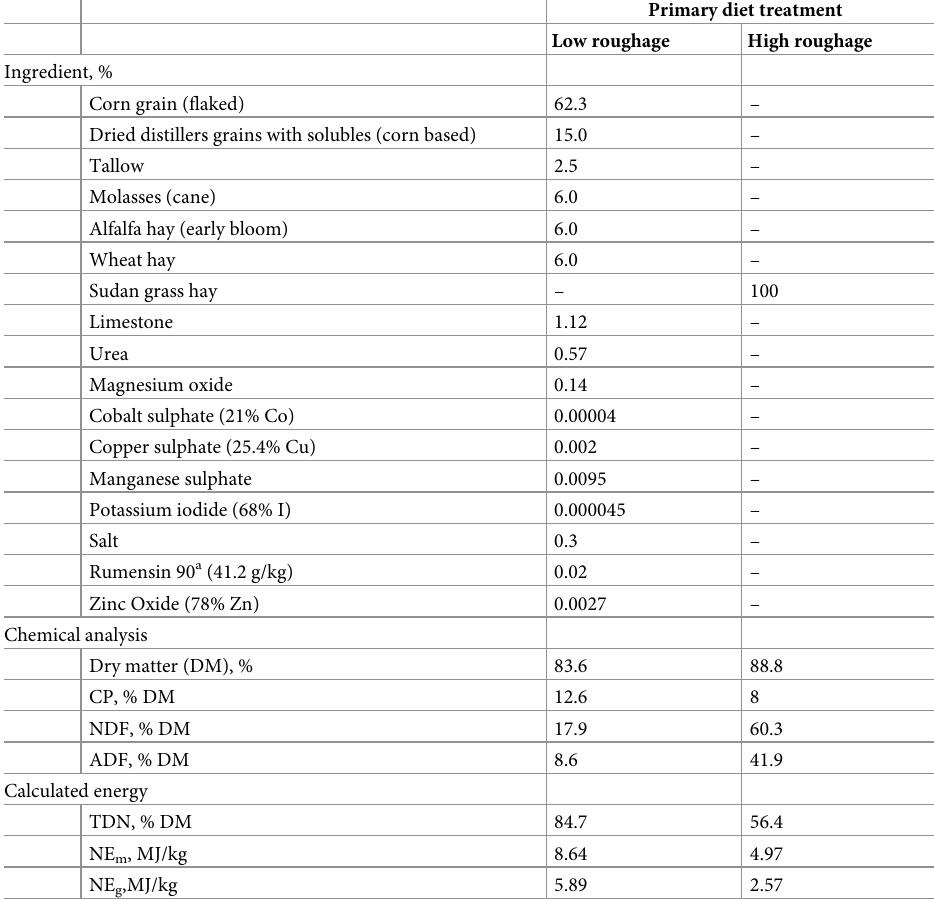
Table 1. Ingredients, chemical analysis, and calculated energy for the primary